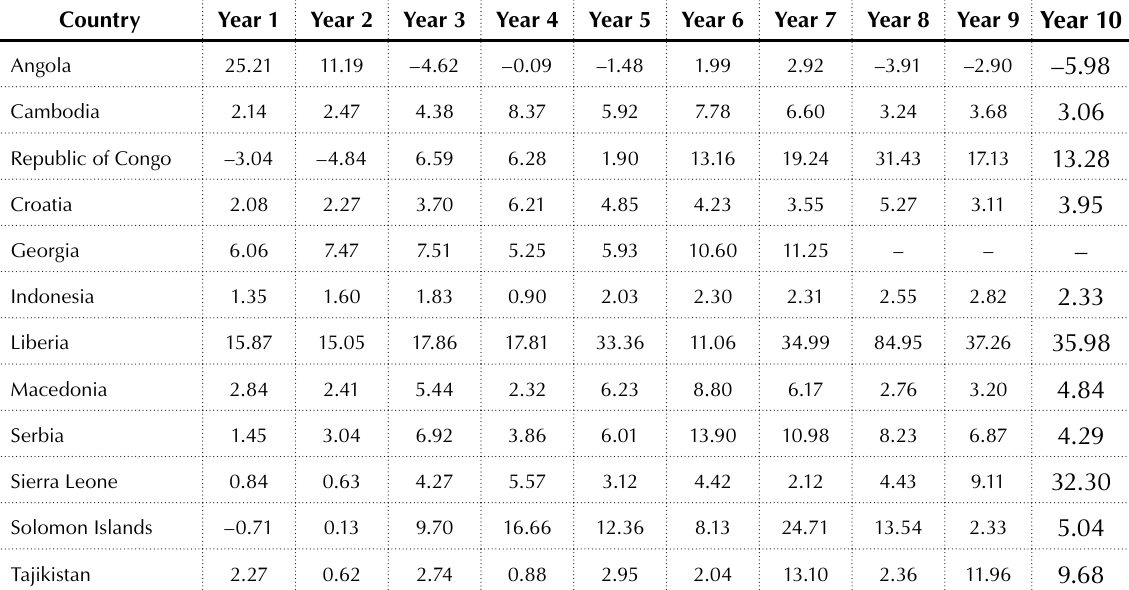
Source: World bank Open